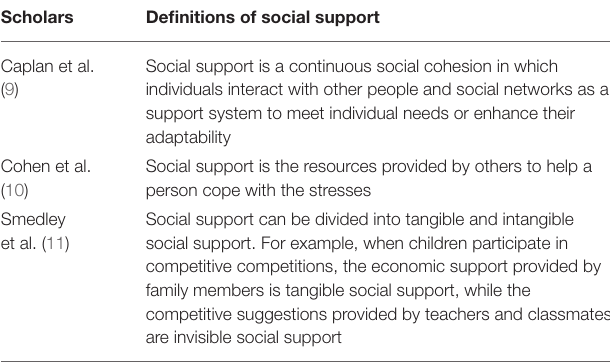
TABLE 1 | Conceptualization of social